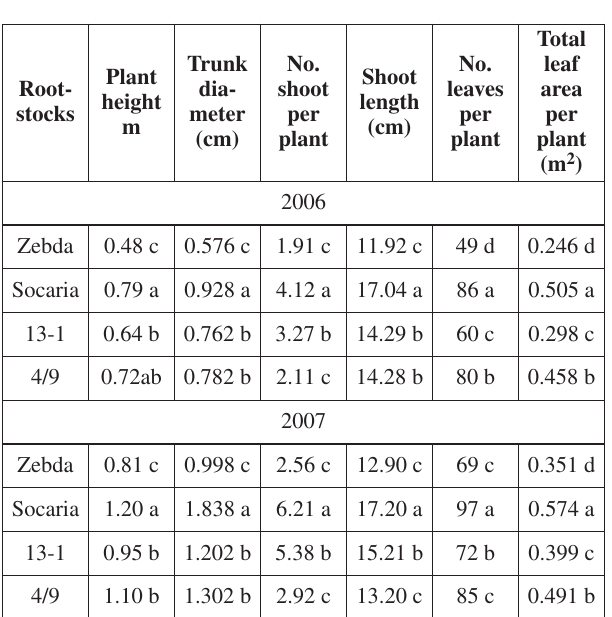
Table 1. Plant height (m), stem diameter (cm), number of shoot per plant, average shoot length, number of leaves per plant and area per leaf of Keit mango variety as affected by grafting on the four mango rootstocks in 2006 and 2007.